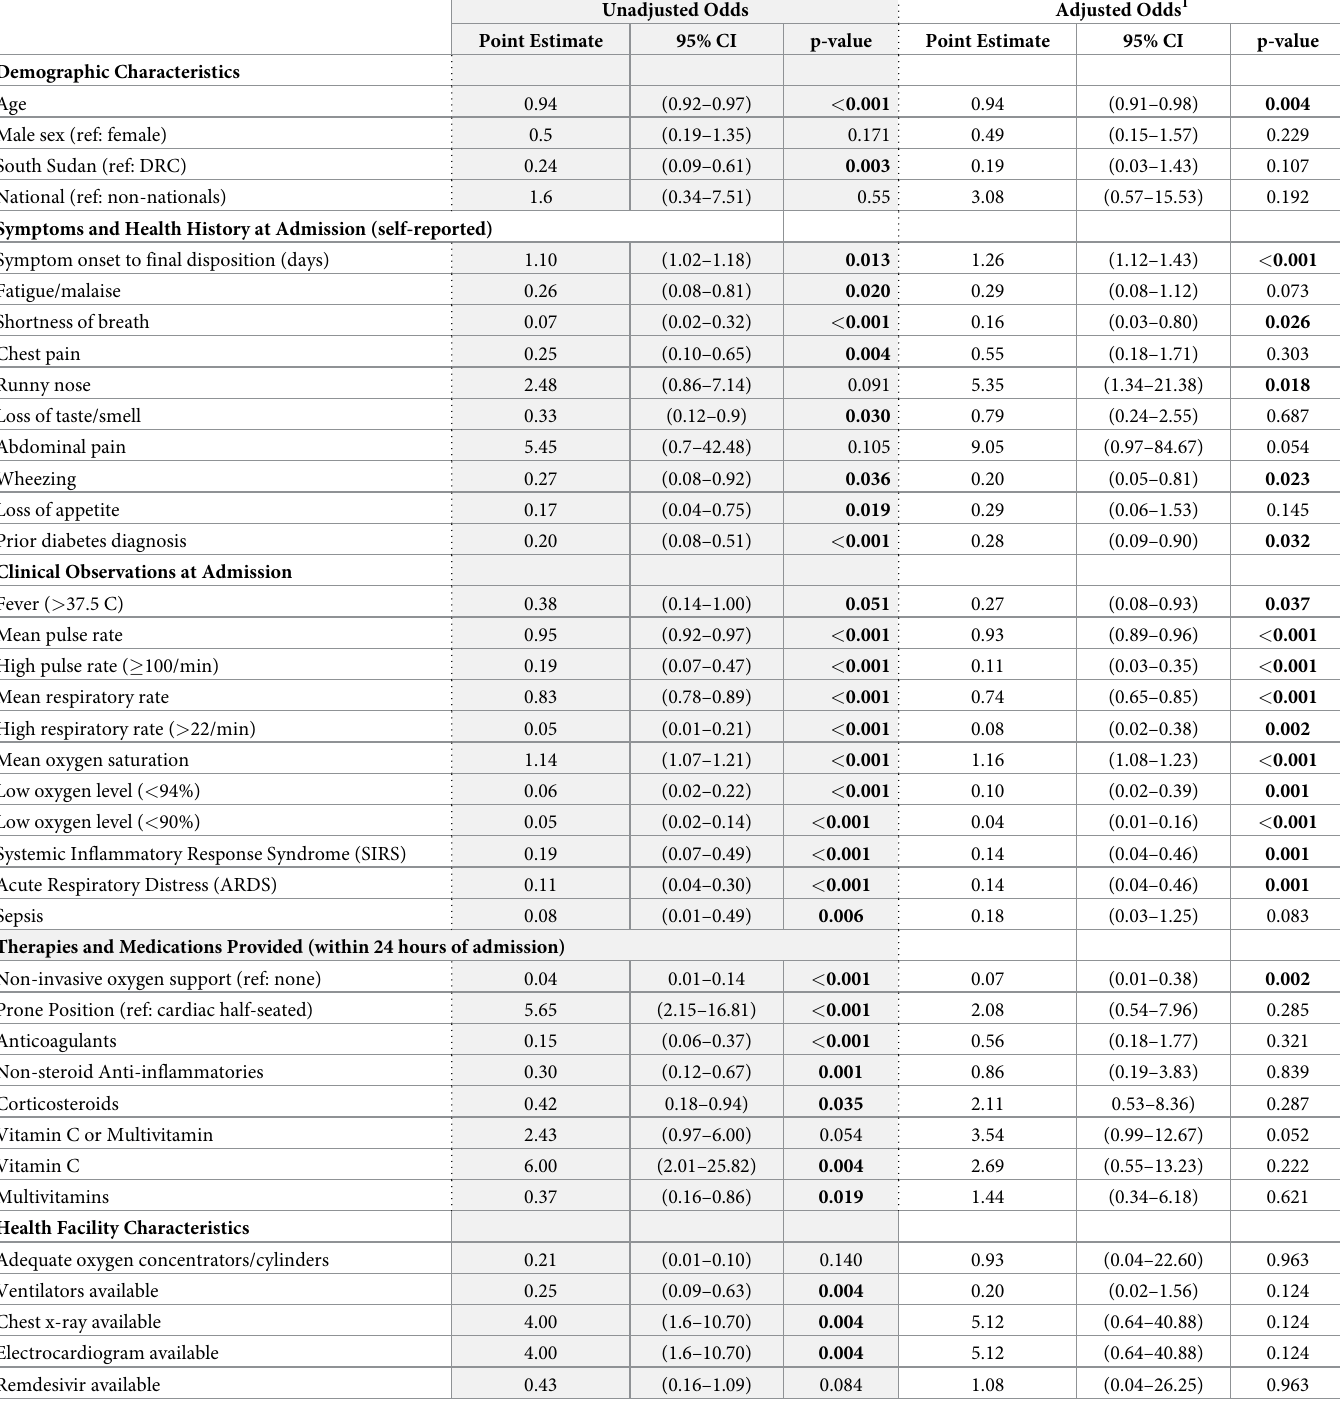
Table 3. Unadjusted and adjusted odds of survival by select patient characteristics and treatments